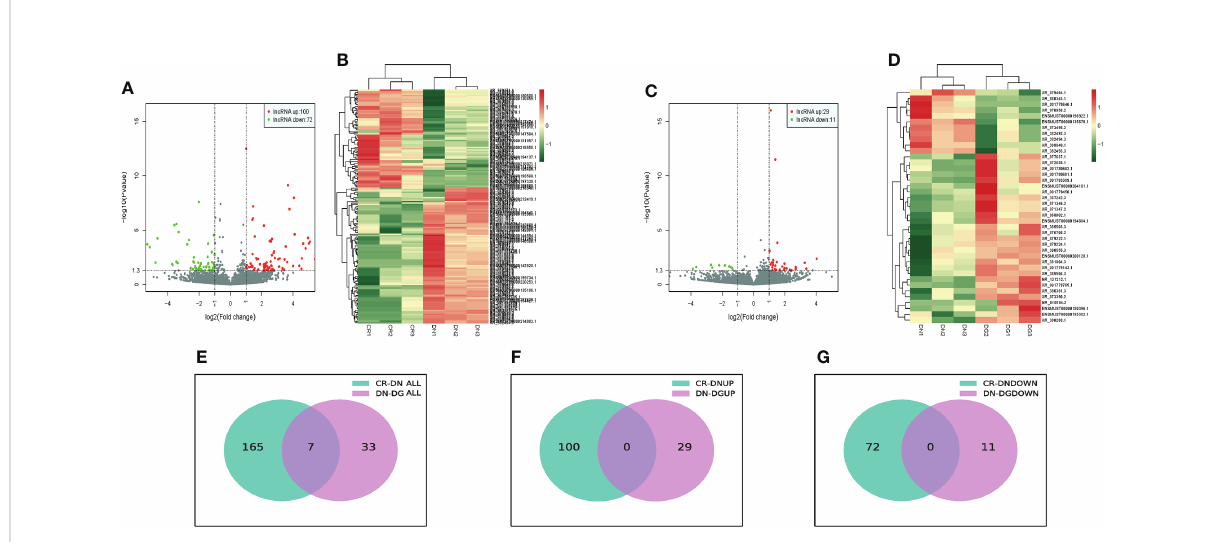
FIGURE 2 Differentially expressed LncRNAs in DN (n=3). (A, B) Volcano plots (A) and heatmaps (B) for comparison between CR and DN. (C, D) Volcano plots (C) and heatmaps (D) for comparison between DN and DG. (E) Overlap of the differentially expressed LncRNAs in the comparisons between CR vs DN and DN vs DG. (F) Upregulated differentially expressed LncRNAs in the comparisons between CR vs DN and DN vs DG. (G) Downregulated differentially expressed LncRNAs in the comparisons between CR vs DN and DN vs DG. CR, control group; DN, diabetic nephropathy group; DG, dapagli fl ozin